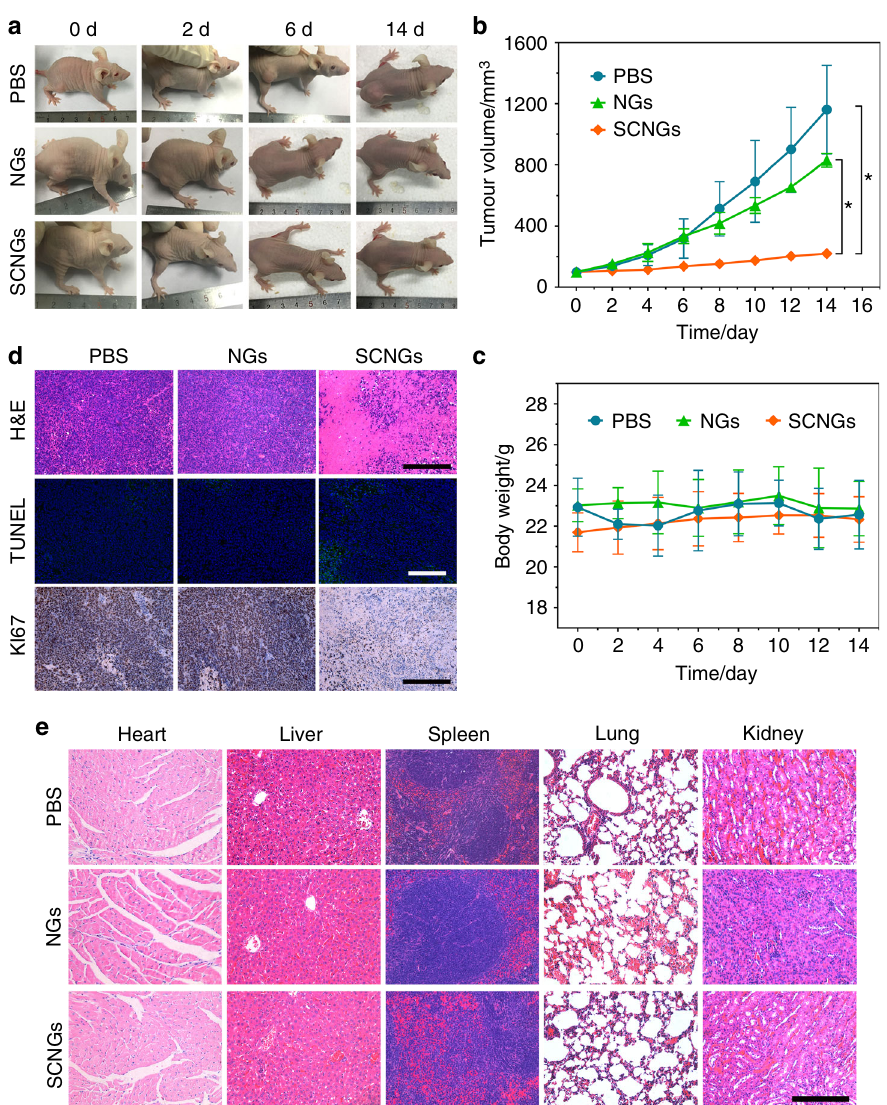
Fig. 6 In vivo EDT on HepG2 cell derived mouse model. a Photographs on the 0, 2nd, 6th, 14th day of tumour-bearing mice after various treatments by intravenous injection. Dose: PBS (100 μ L), NGs (100 μ L, 5 mg mL − 1 ), SCNGs (100 μ L, 5 mg mL − 1 ). The relative tumour volume ( b ) and body weight ( c ) change curves of each group of mice in 14 days after various treatments. Date are the means± s.d. ( n = 3). p values were analyzed by Student ’ s two-sided t -test (* P < 0.05). d Histopathology analysis (H&E staining, TUNEL and KI-67 assay) of the tumour tissue after 14 days of different treatments. Scale